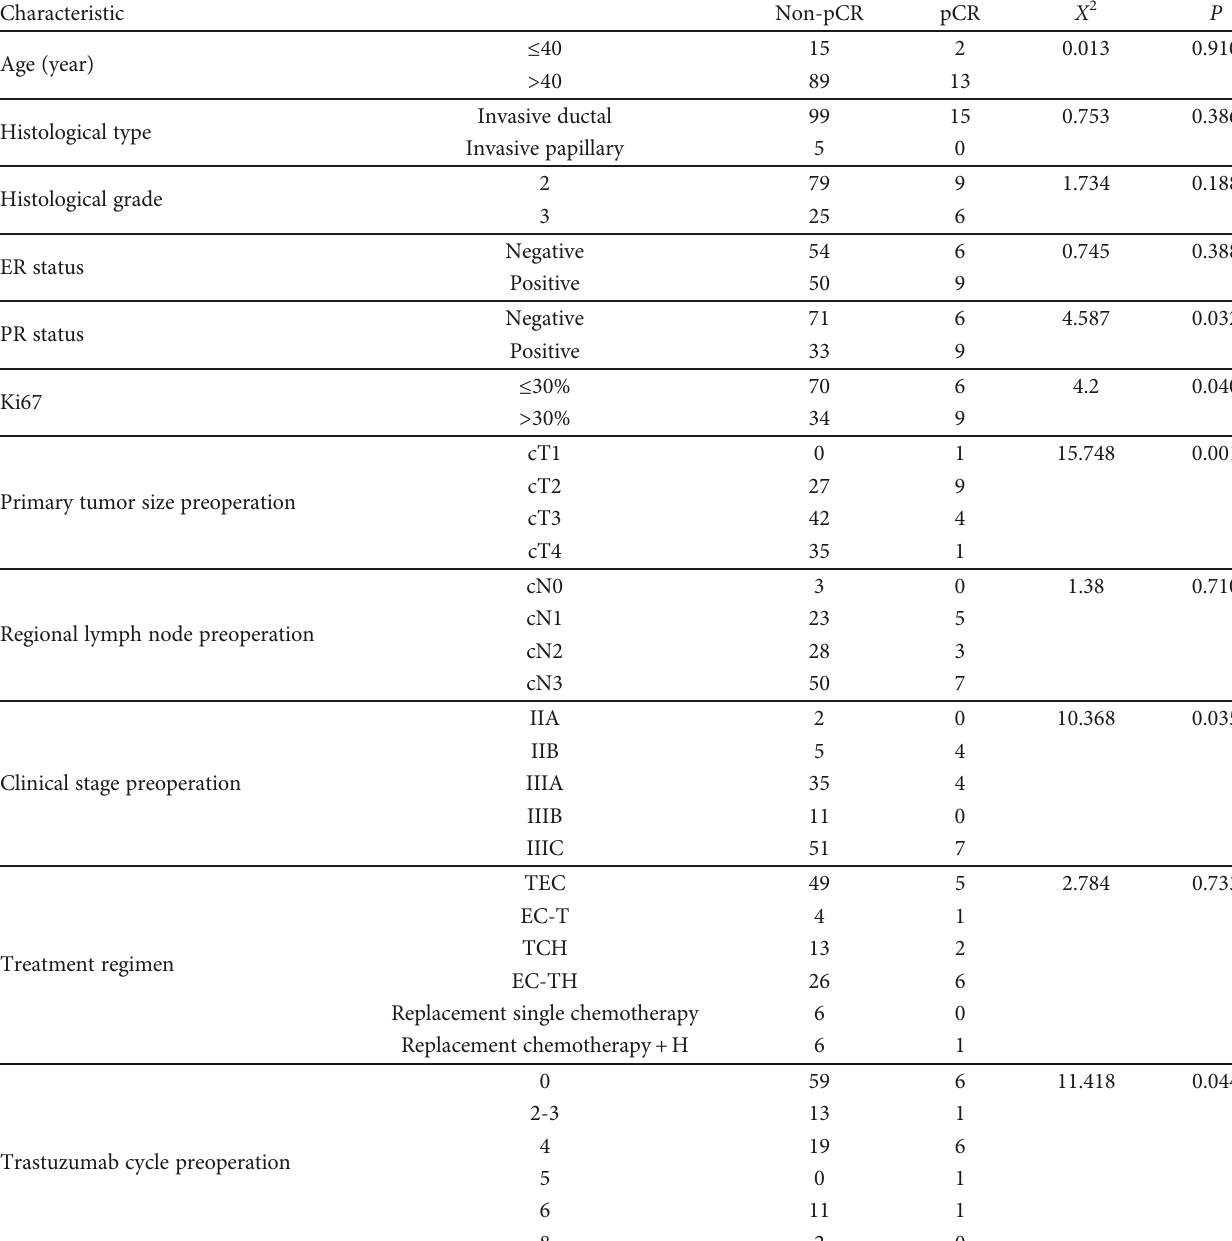
Table 1: Univariate analysis of factors associated with pCR.